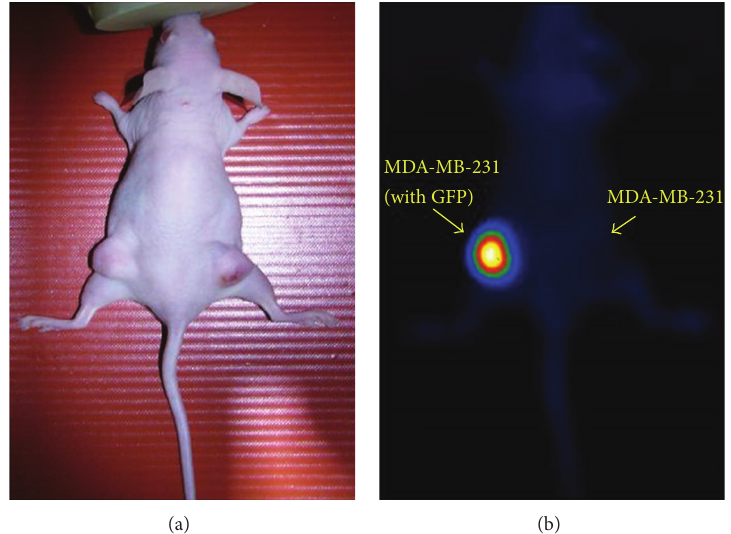
Figure 4: White light (a) and fluorescence (b) images of nude mouse bearing xenografts comprised of GFP-expressing MDA-MB-231 cells on animal’s left thigh and nonfluorescent MDA-MB-231 cells on animal’s right thigh.